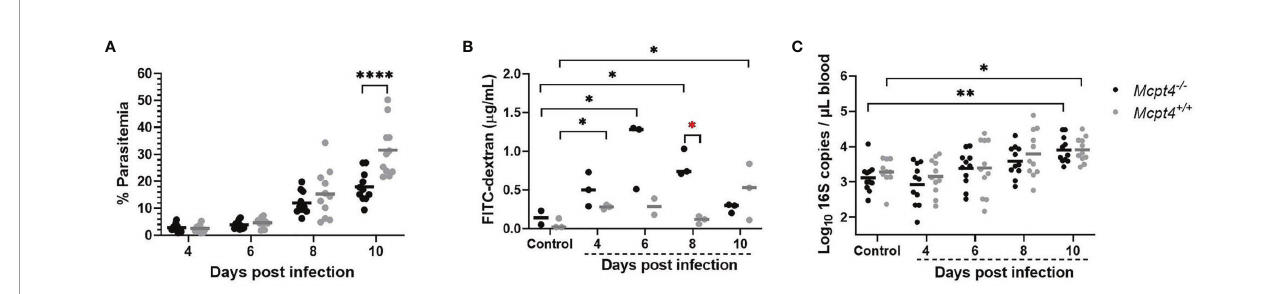
FIGURE 1 | Plasmodium y. yoelii 17XNL parasitemiawas decreased, intestinal permeability to FITC-dextran was increased,but bacteremia over time was not different in Mcpt4 -/- relative to Mcpt4 +/+ mice. (A) Peripheral parasitemia following P. y. yoelii 17XNL infection, (B) intestinal permeability quanti fi edas FITC-dextran in plasma ofinfected anduninfected mice after oral gavage and (C) bacterial 16S DNA copies/µL ofblood in infectedand uninfectedmice. Each dot represents a singlemouse. Parasitemiaand bacterial 16S copies were determined for the three replicates (n=11 per group, per time point), whileFITC-dextran was determined using the last replicateof mice only (n=3 mice per groupper time point). Parasitemiaand log 16S copies per m L of bloodwere analyzed usingone-way ANOVA followed byDunnett ’ s orS ̌ ı ́ da ́ k ’ s multiplecomparisons test; lines represent the mean.FITC-dextran data were analyzed with the Kruskal-Wallistest followed byDunn ’ s test for multiplecomparisonsfor each timepoint versus control orbetween Mcpt4 -/- and Mcpt4 +/+ miceat speci fi c time points; lines represent the median.P values ≤ 0.05 were considered signi fi cant. *P ≤ 0.05, **P ≤ 0.01, ****P ≤